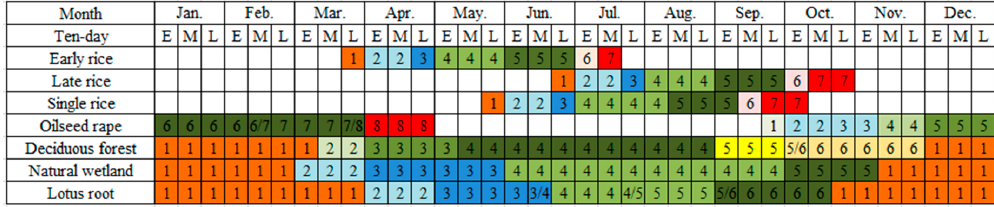
Figure 4. Phenology of land-cover types found in our study area. Rice: 1—sowing, 2—seedling,